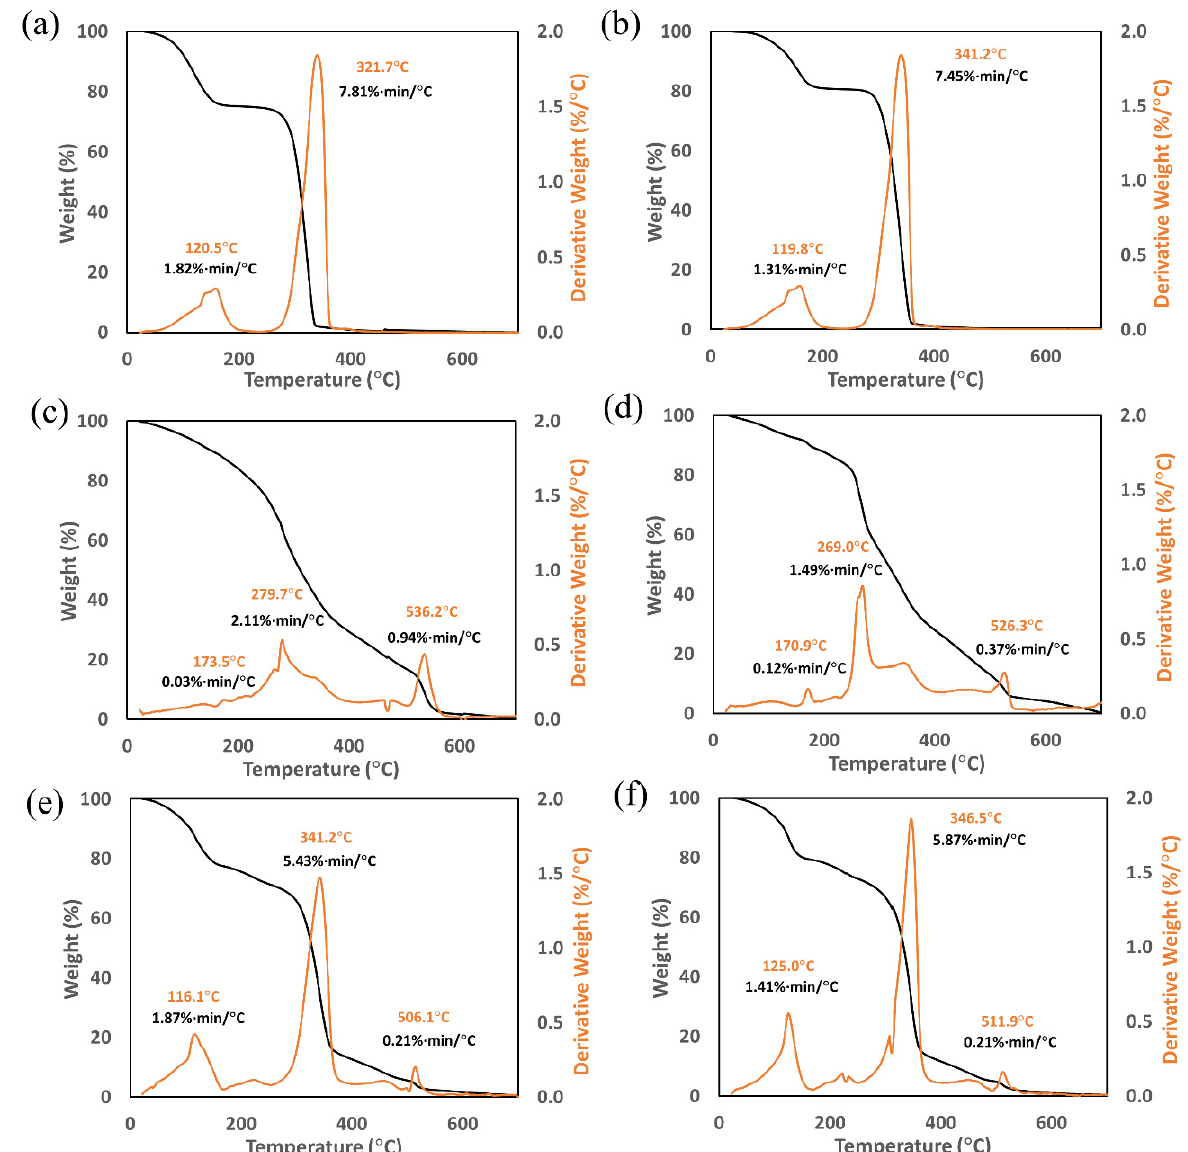
Figure 2. TGA thermograms of the solvent-cast samples prepared using HFP: ( a ) untreated PLGA, ( b ) plasma-treated PLGA, ( c ) untreated collagen, ( d ) plasma-treated collagen, ( e ) untreated PLGA- collagen, and ( f ) plasma-treated PLGA-collagen.